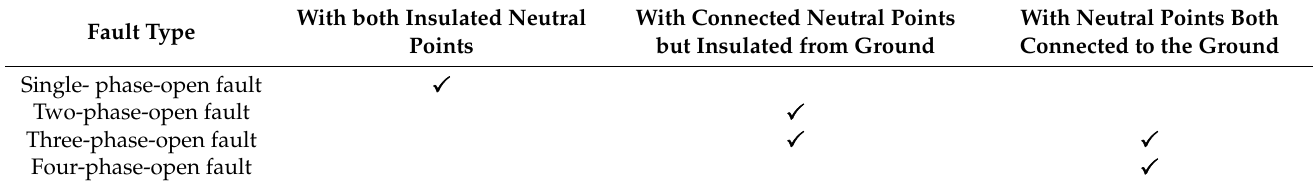
Table 6. The Connection Modes for the Open-Fault Solutions.